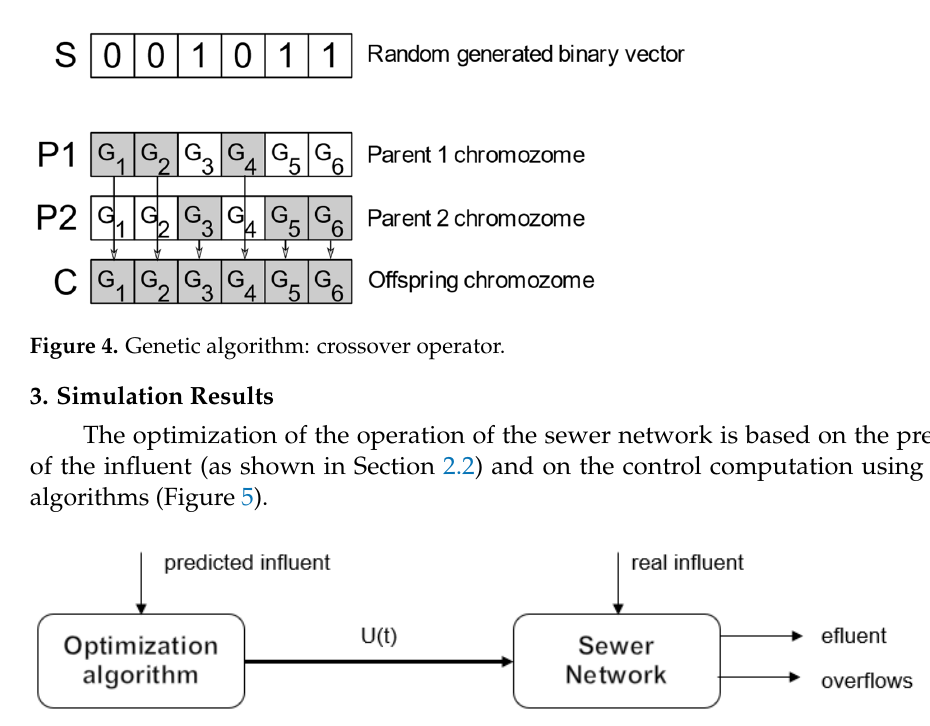
Figure 5. Optimal control of the sewer network.